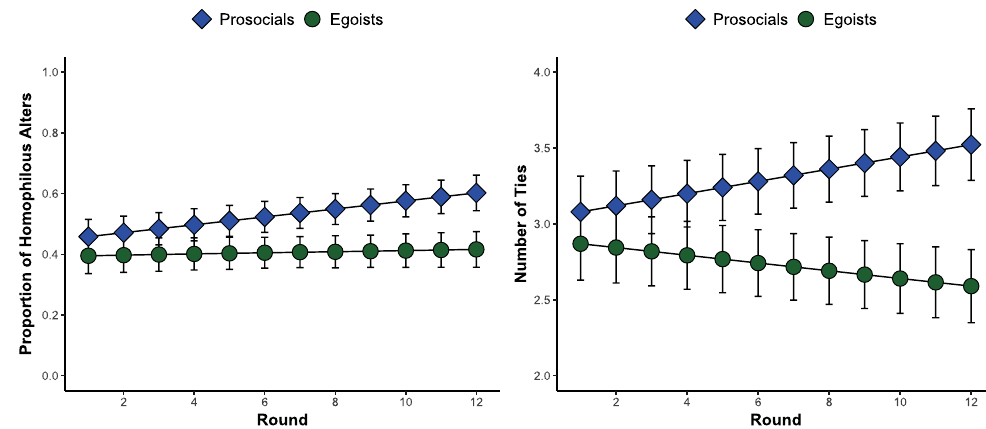
Figure 2. Marginal ( A ) homophily (proportion of alters that have the same Social Value Orientation as ego) and ( B ) number of ties (the count of ties for each participant) in heterogeneous dynamic networks. In terms of number of ties, each participant began with three ties but marginal means are shown. Error bars refer to 95% confidence intervals around the marginal means.